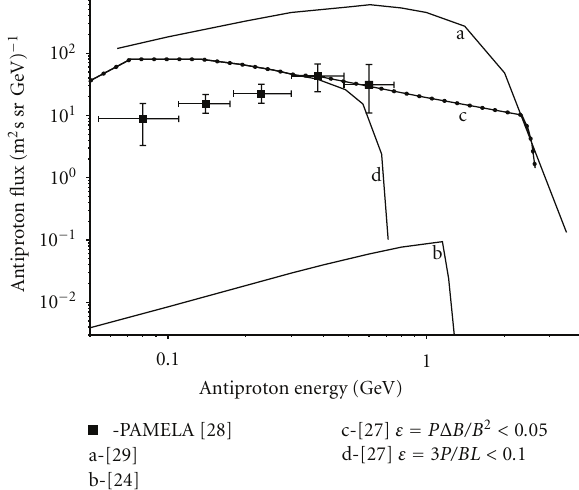
Figure 8: Comparison of results of simulations with data of PAMELA experiment: ε is the criterion of stable trapping, P is the particle moment and B is geomagnetic field strength